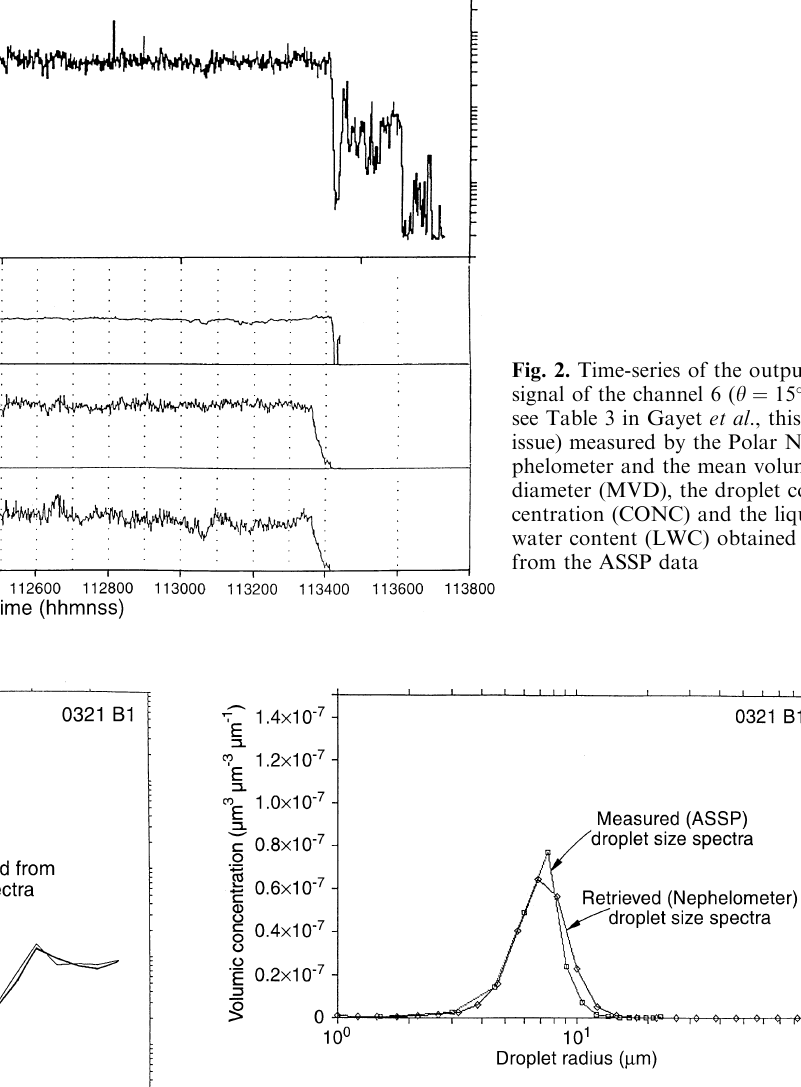
Fig. 4. Comparison between the retrieved (Nephelometer) and direct (ASSP) size distributions relative to the B1 period (see Fig. 2)